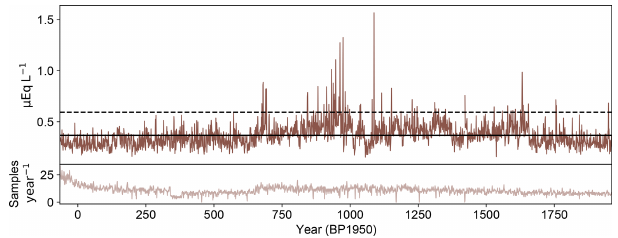
Figure 13. Time series for annually averaged nitrate. Solid black line indicates the 2000-year mean value. Dashed black line indi- cates 2 σ value. The lower panel indicates the number of individual samples in the year used for the average value.